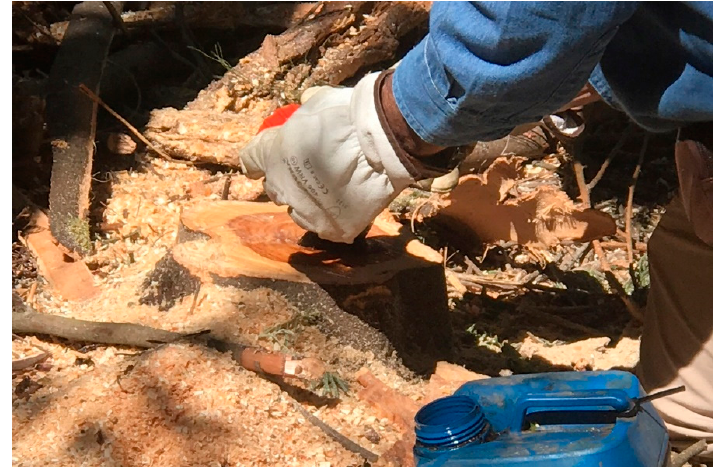
Figure 9. Application of herbicide, in this case glyphosate, after cutting an Acacia dealbata tree.